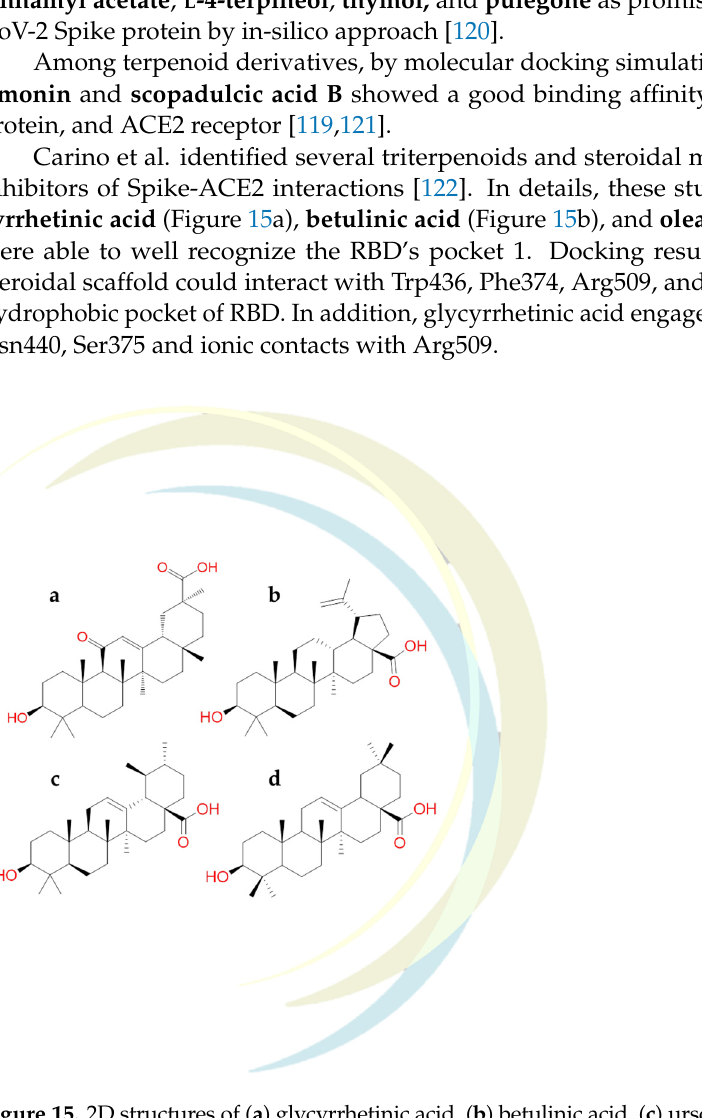
Figure 16. 2D structures of ( a ) chenodeoxycholic acid, ( b ) ursodeoxycholic acid, ( c ) Glyco-ursode- oxycholic acid, ( d ) glyco-chenodeoxycholic acid, ( e ) withanolide N, ( f ) dihydrowithaferin A, ( g ) ashwagandhanolide, ( h ) withanoside X, (i) withanoside V. In addition to the activity against ACE2, the binding affinity of triterpene derivatives and steroid-based compounds against SARS-CoV-2 Mpro was explored. The ursodeoxycholic